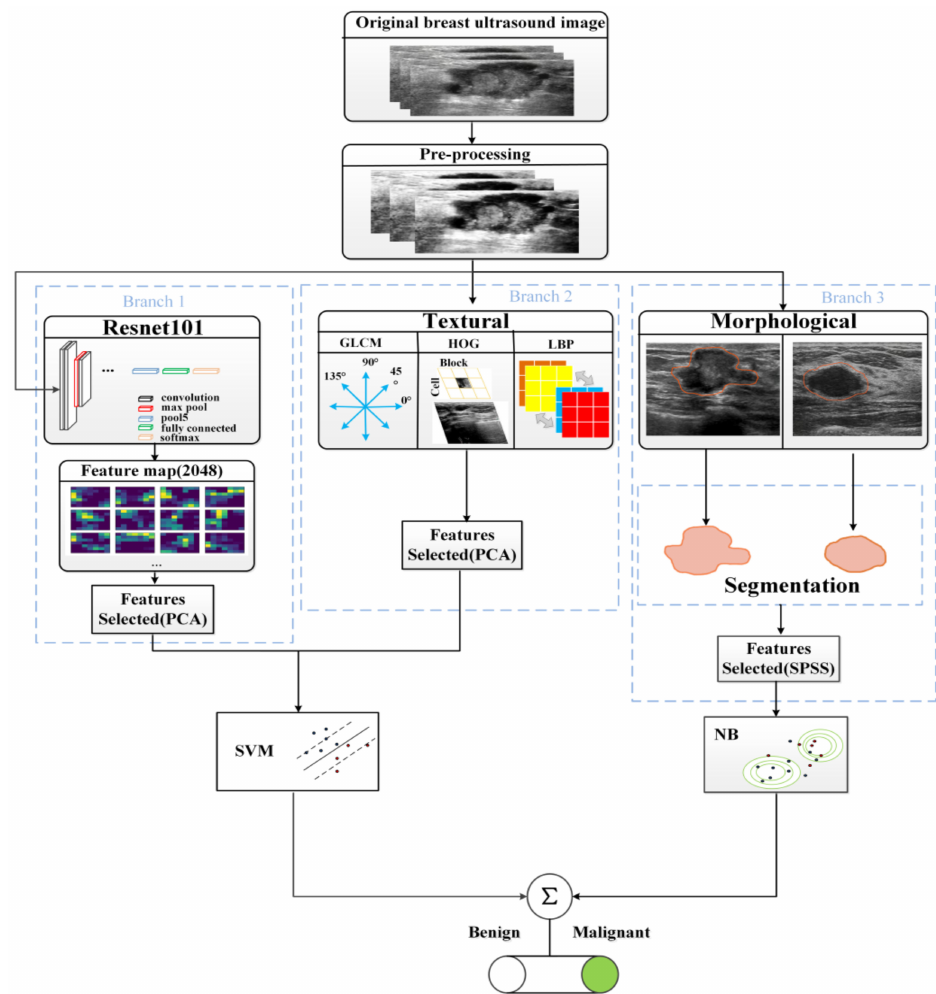
Figure 1. The flow chart of the proposed MfdcModel for benign and malignant classification of breast tumors. It is based on the fusion of SVM (support vector machine) and NB (naive Bayes) classifiers with global deep residual network features, texture features, and morphological features. Σ represents the weighted fusion of the SVM and NB